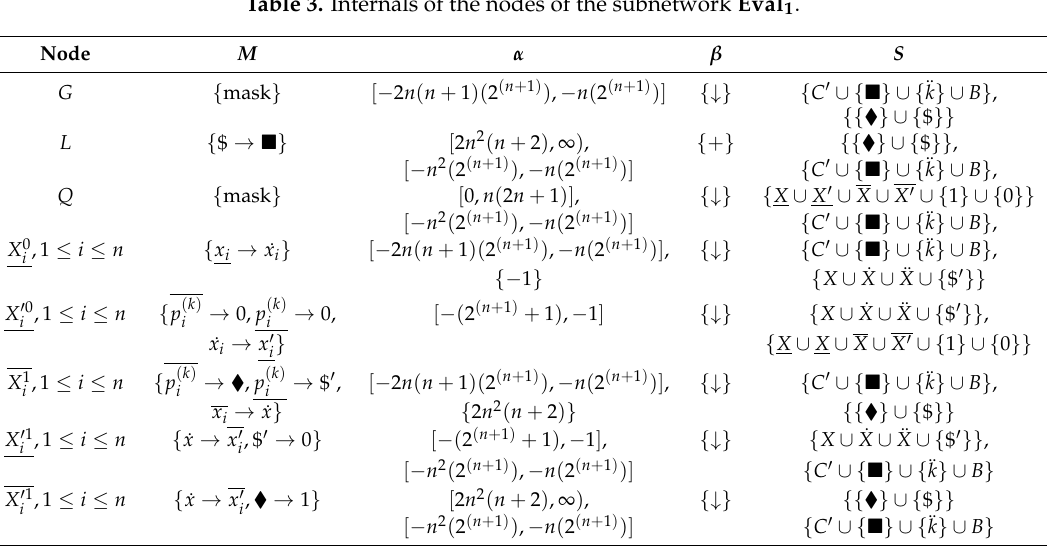
Table 3. Internals of the nodes of the subnetwork Eval 1